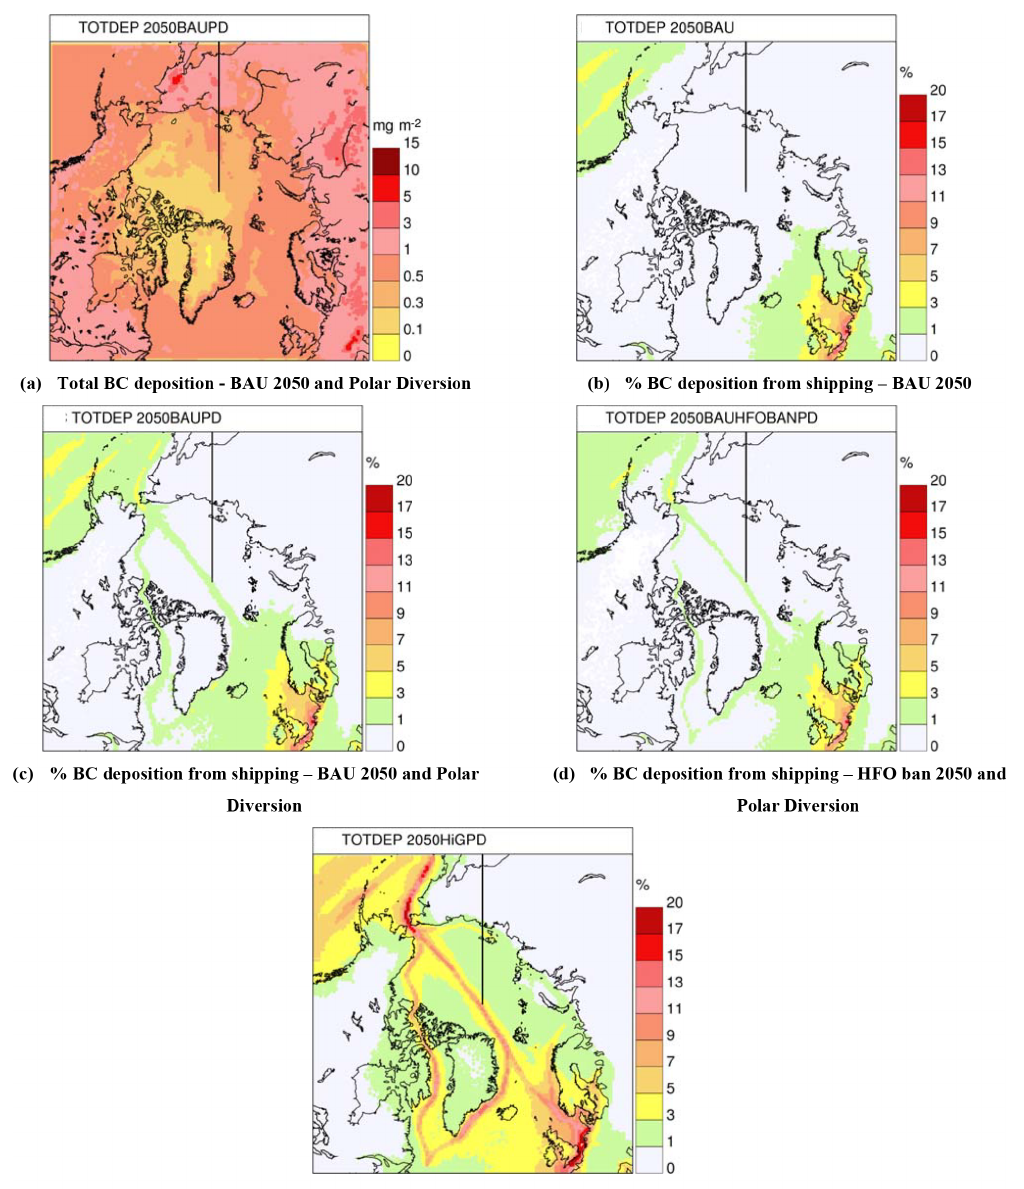
Figure 10. (a) The total BC deposition across the Arctic and Nordic regions in the BAU 2050 scenario in the DEHM d02 domain. Panels (b) and (c) display the contribution from shipping without and with the polar diversion, while panels (e) and (d) display the contribution in the HFO ban and High-Growth traffic scenarios (both including the polar